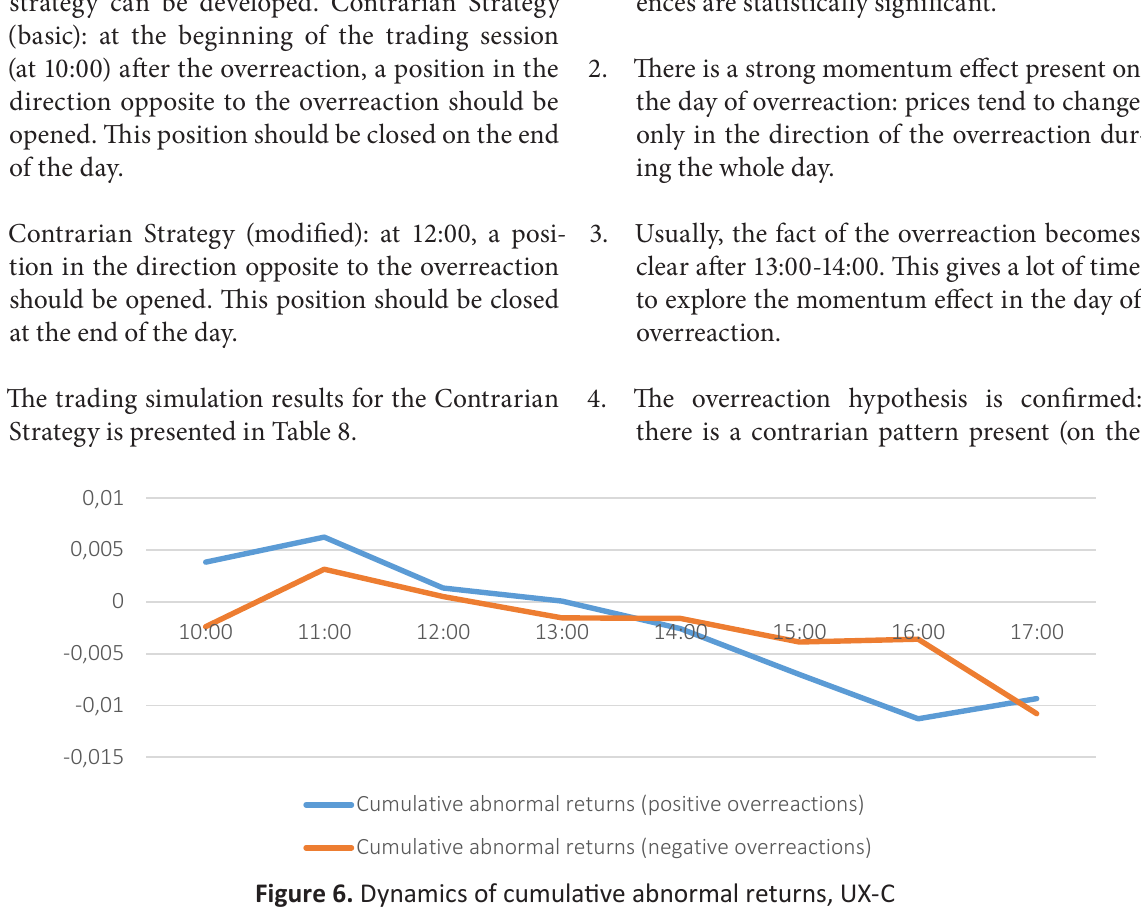
Figure 6. Dynamics of cumulative abnormal returns, UX-C